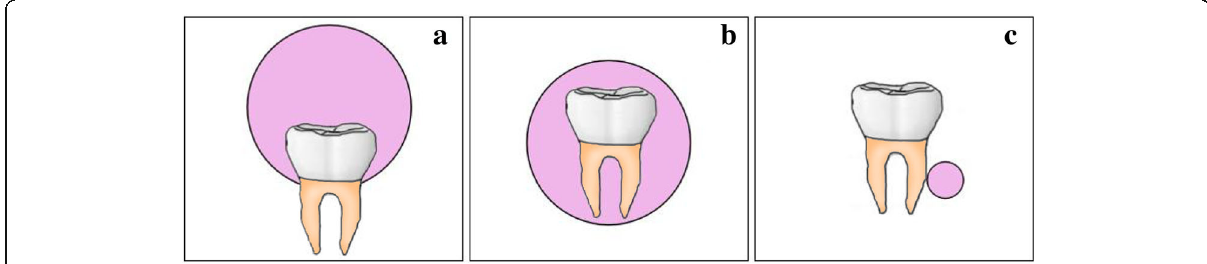
Fig. 4 Schematic overview of the POT location and involved tooth. a Type A, POT has a pericoronal location in a dentigerous relationship. b Type B, the tumor appears to completely envelop an embedded tooth. c Type C, the POT is in close proximity to the root of the